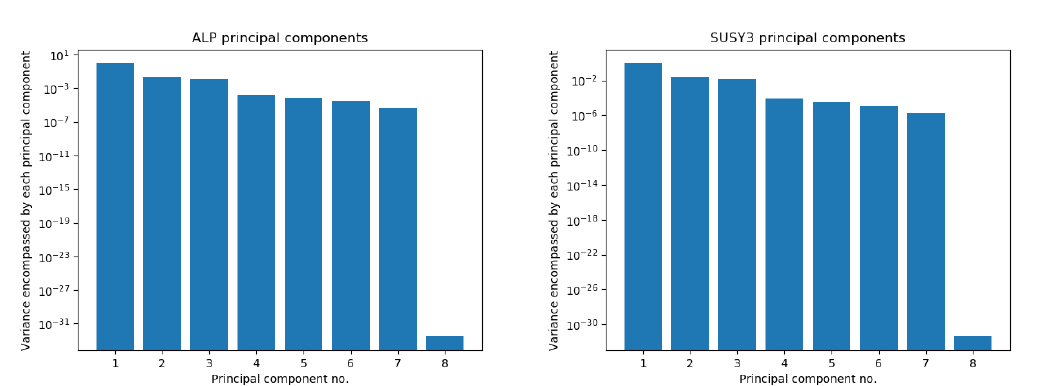
Figure 10: The explained variance ratio of the new principal component axes (with the number of principal component axes being 8, the same number of original fea- tures), highlighting the relative importance of the principal components in terms of capturing variance in the datasets.